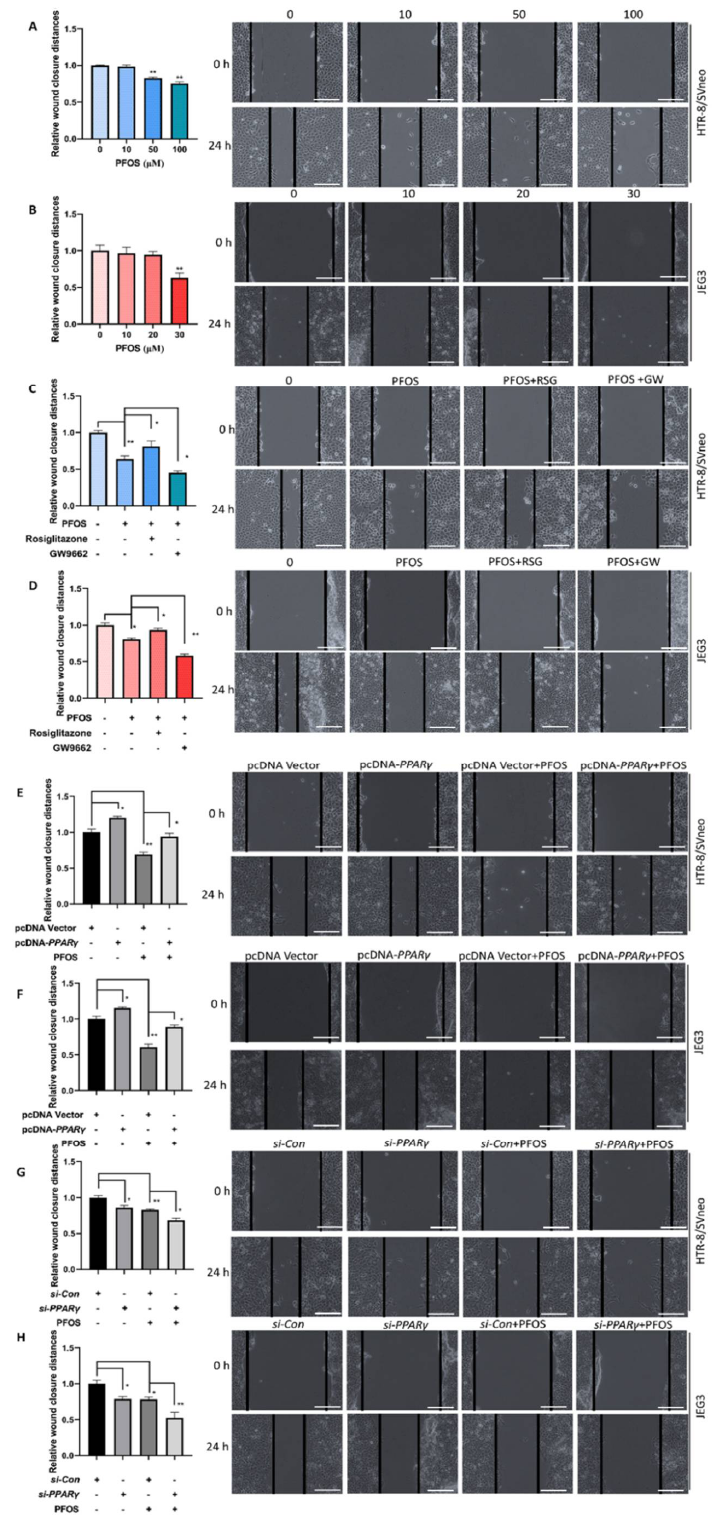
Figure 2. Effect of PPARγ on migration exposed to PFOS in vitro. The distances of the wound healing were measured after exposure of PFOS at 0 h and 24 h ( A , B ), exposure of PFOS in the absence or presence of rosiglitazone and GW9662 ( C , D ), with PPAR γ overexpression ( E , F ) and knocking down ( G , H ) in HTR-8/SVneo and JEG-3 cells (50 µ M for HTR-8/SVneo, 30 µ M for JEG-3. Scale bar: 200 µ m). The data are shown as the means ± S.E.M. * p < 0.05; ** p < 0.01; compared with the indicated group, n =